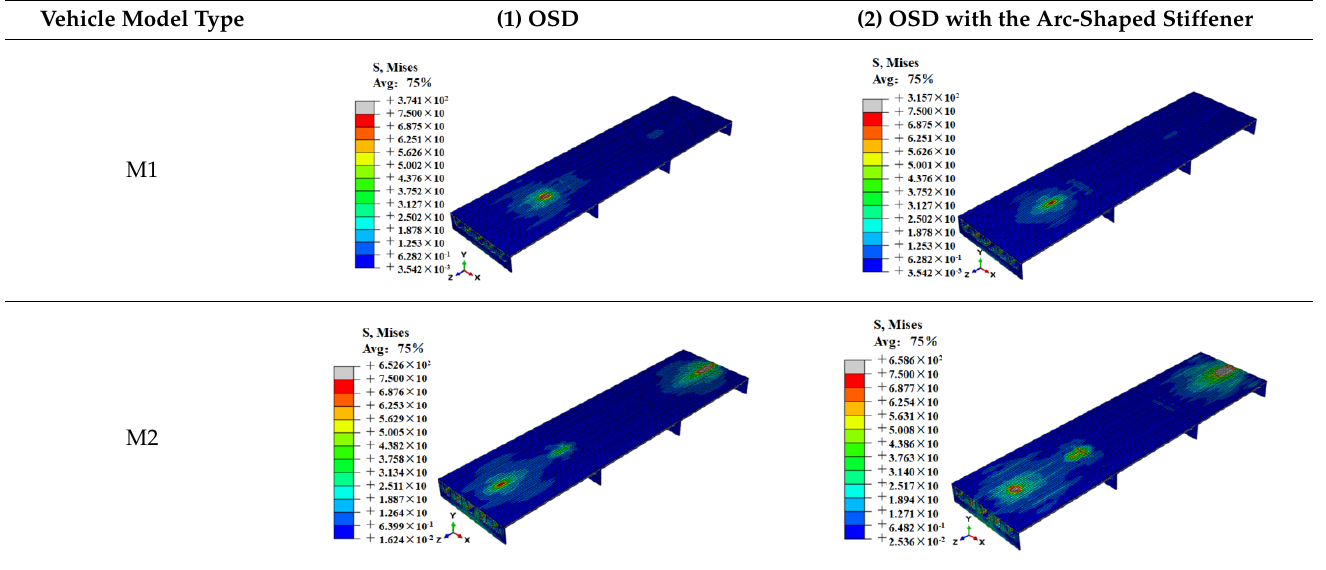
Table A1. Stress state of steel bridge deck under moving vehicle M1–M6 (MPa). Vehicle Model